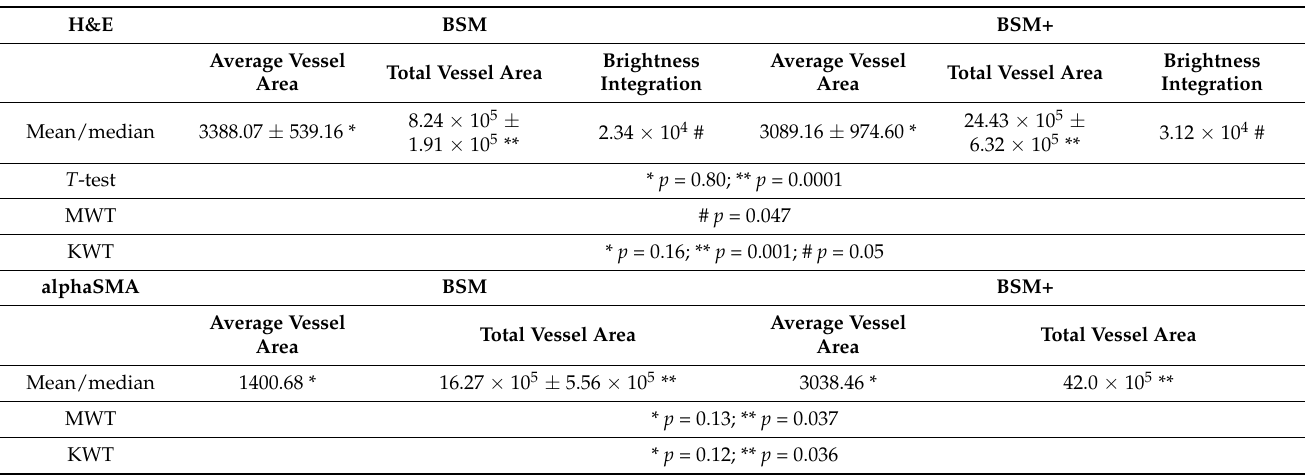
Table 3. Analysed H&E and alphaSMA staining for average area of vessel staining, total area, and brightness integration (only H&E) by the BSM and BSM+ groups on day 6 ( n = 24 for each group, two